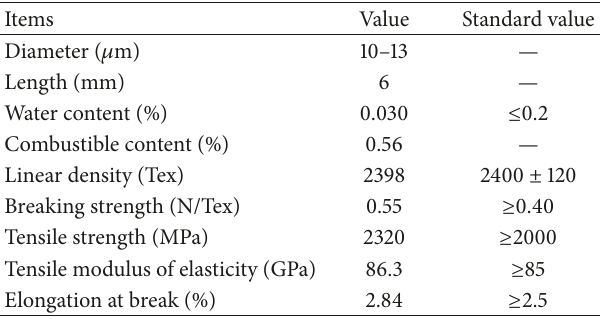
Table 3: Properties of basalt fiber (provided by manufacturer).